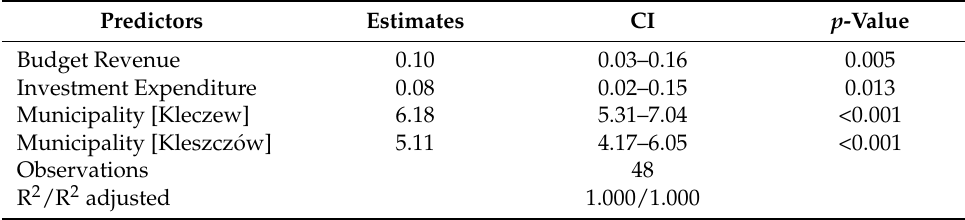
Table 11. Least-squares dummy variables (LSDV)